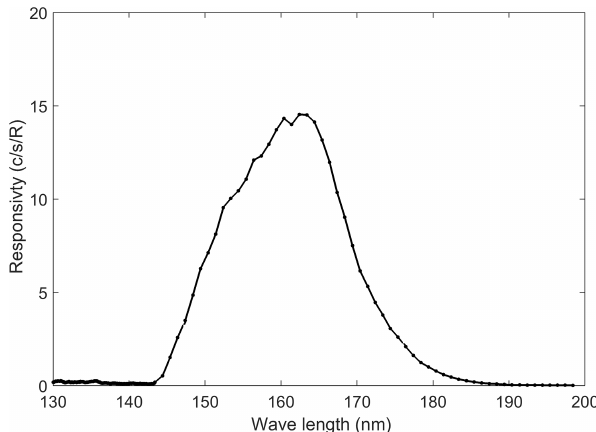
Figure 5. The IPM responsivity of the N 2 LBH channel in